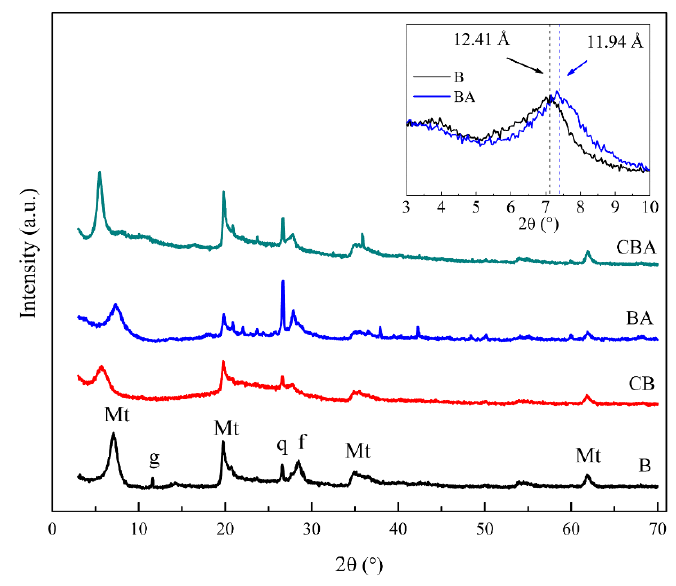
Figure 3. Diffractograms of natural bentonite (B), bentonite composite (CB), activated bentonite (BA), and activated bentonite composite (CBA). Mt: montmorillonite; q: quartz; f: feldspar; and g: gypsum. The inserted figure shows the extended zone of 2 = 3 – 10° for solids B and BA.